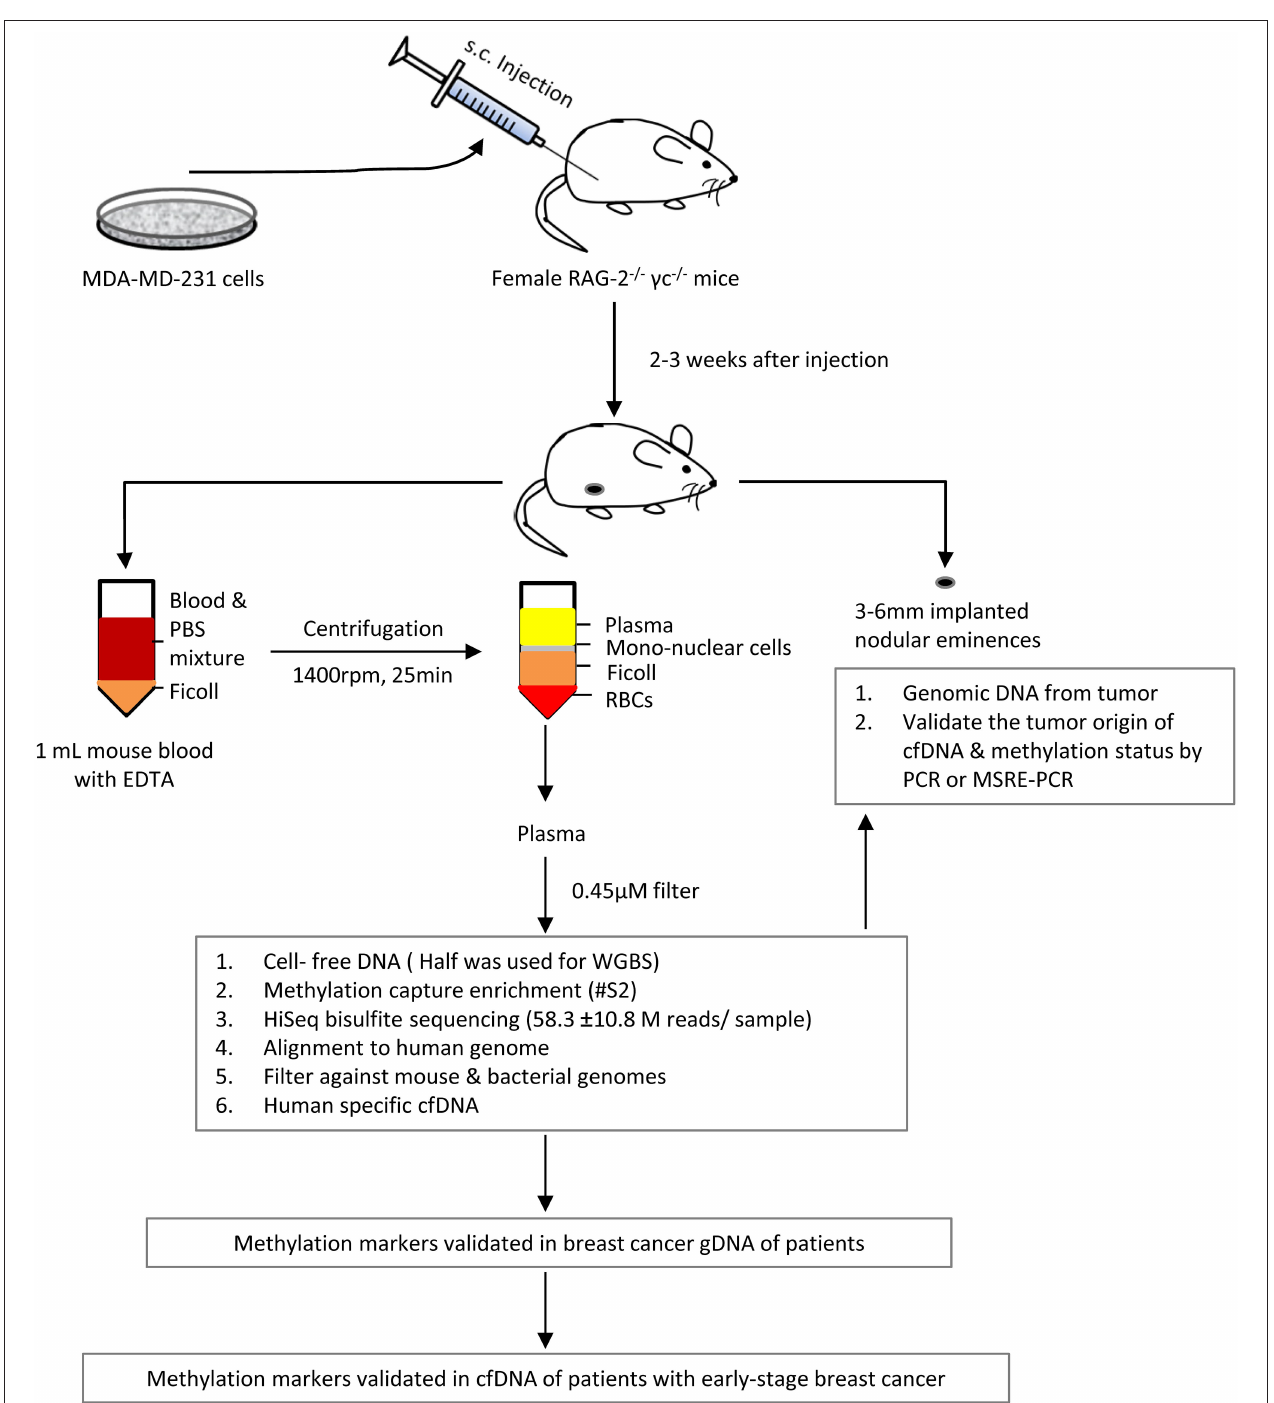
FIGURE 1 | Outline of the identification of plasma cfDNA of tumor origin in mice xenografted with human breast cancer MDA-MD-231 cells, using whole genome bisulfite deep sequencing and/or methyl-DNA capture.